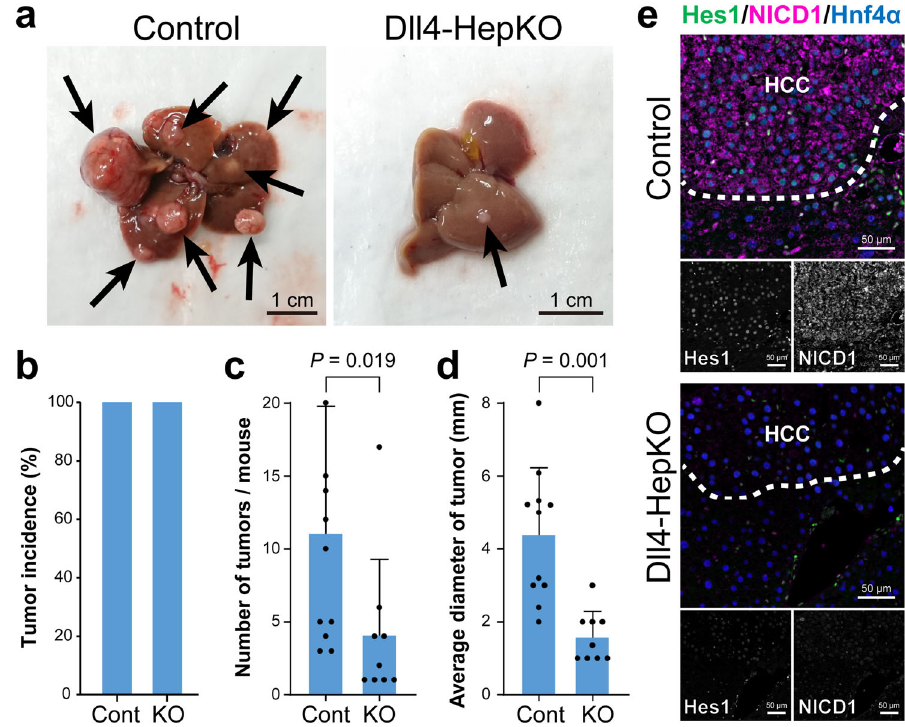
Fig. 3 Development of HCC suppressed by the hepatocyte-speci fi c deletion of Dll4 . a Representative macroscopic pictures of liver tumors observed in DEN-treated male control or hepatocyte-speci fi c Dll4 knockout mice (Dll4-HepKO). Arrows indicate the tumors observed on the liver surface. The histograms show the incidence of development of tumors ( b ), the mean number of tumors ( c ), and the average size of tumors ( d ) observed in the control (Cont) and Dll4-HepKO (KO) mice. The values represent the mean ± SD in 11 samples from the control mice and nine samples from the Dll4- HepKO mice. e Excised HCC specimens were subjected to immuno fl uorescent co-staining using antibodies against Hes1 ( green ), NICD1 ( magenta ), and Hnf4 α ( blue ). The border between HCC and non-tumorous tissue is indicated by a hatched line. Scale bar, 50 μ